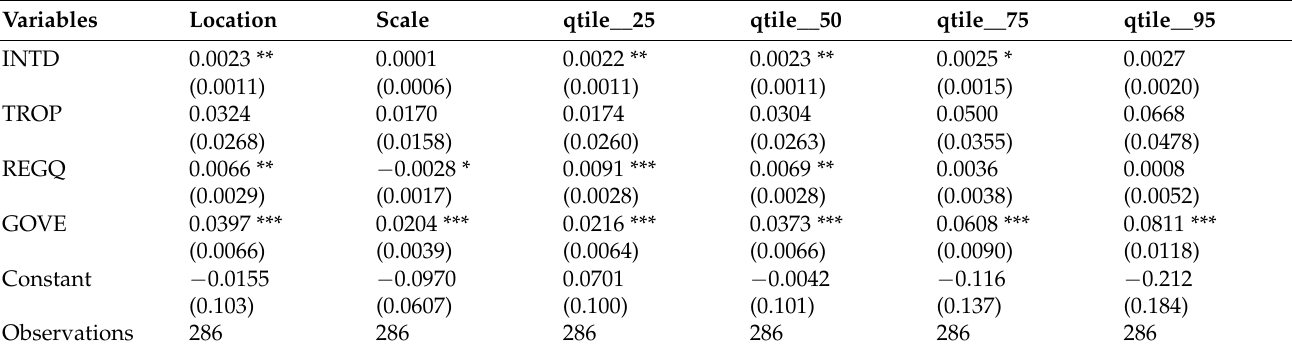
Table 10. Model 8. DV: Income Share of the Bottom 60%